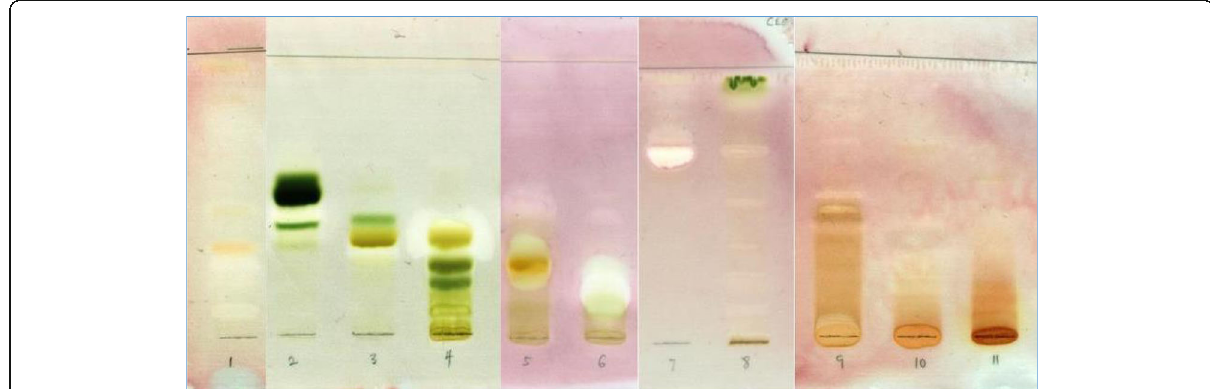
Fig. 1 Bioautography of fractions against M. smegmatis showing clear bands of antimycobacterial activity in chromatograms developed in chloroform/ethyl acetate/formic acid